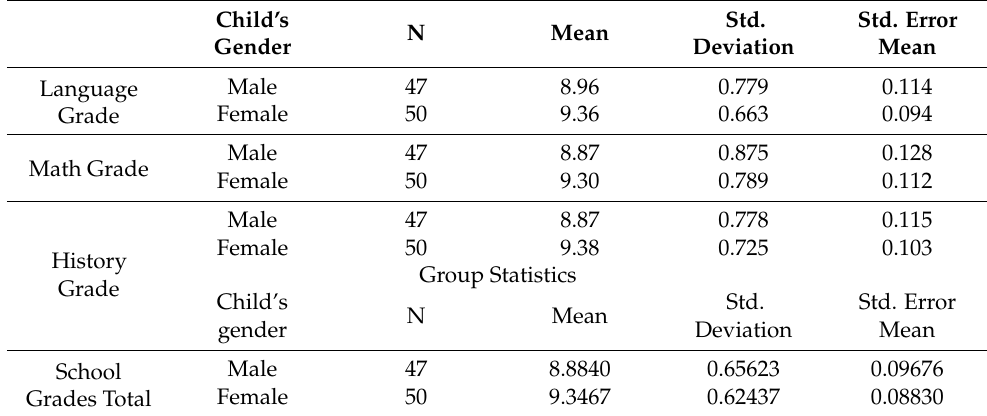
Table 5. Means and standard deviations of subjects by gender.